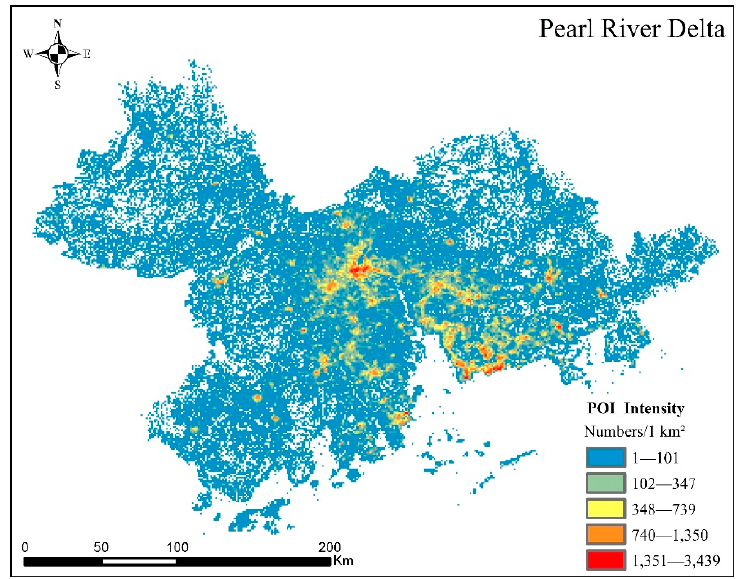
Figure 3. The density distribution of POI data in the PRD urban agglomeration.